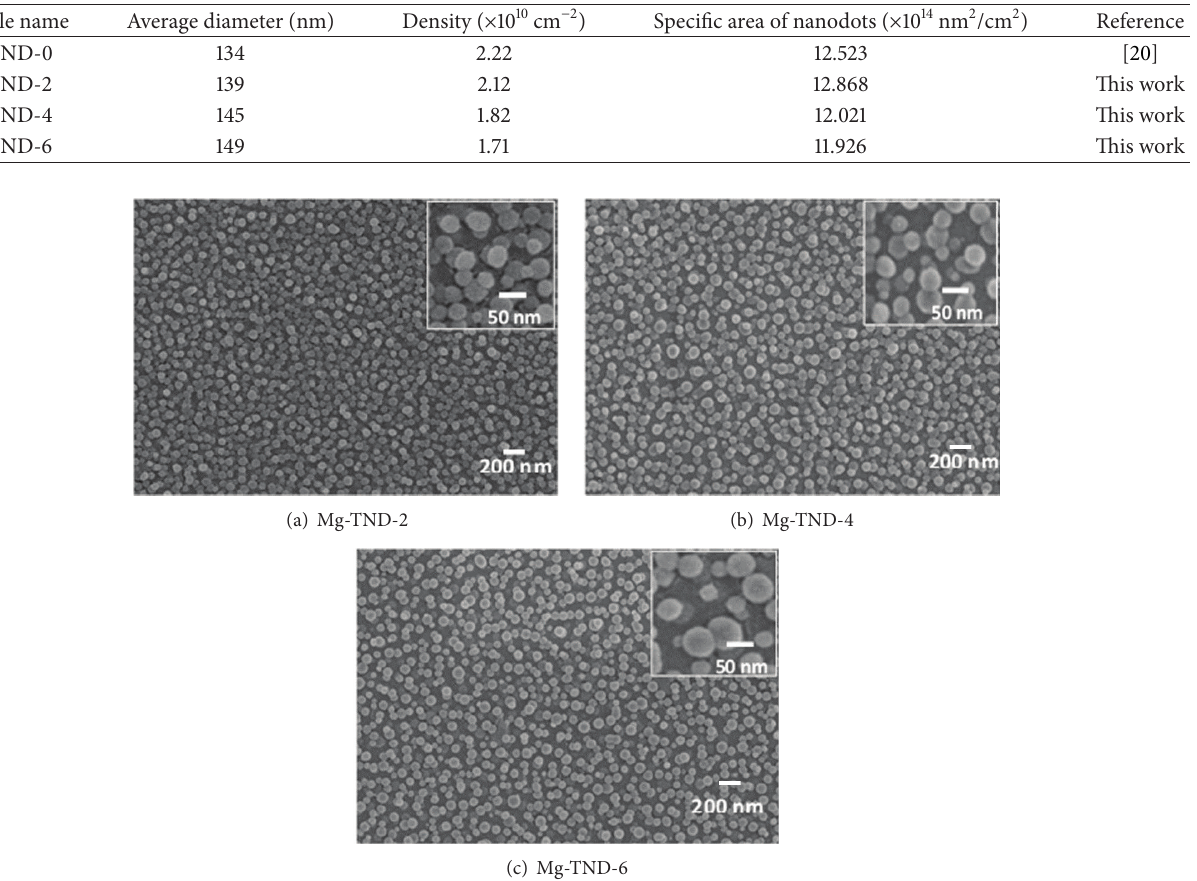
Figure 2: SEM images of TiO 2 nanodots/Ti substrates with various Mg doped concentrations with different